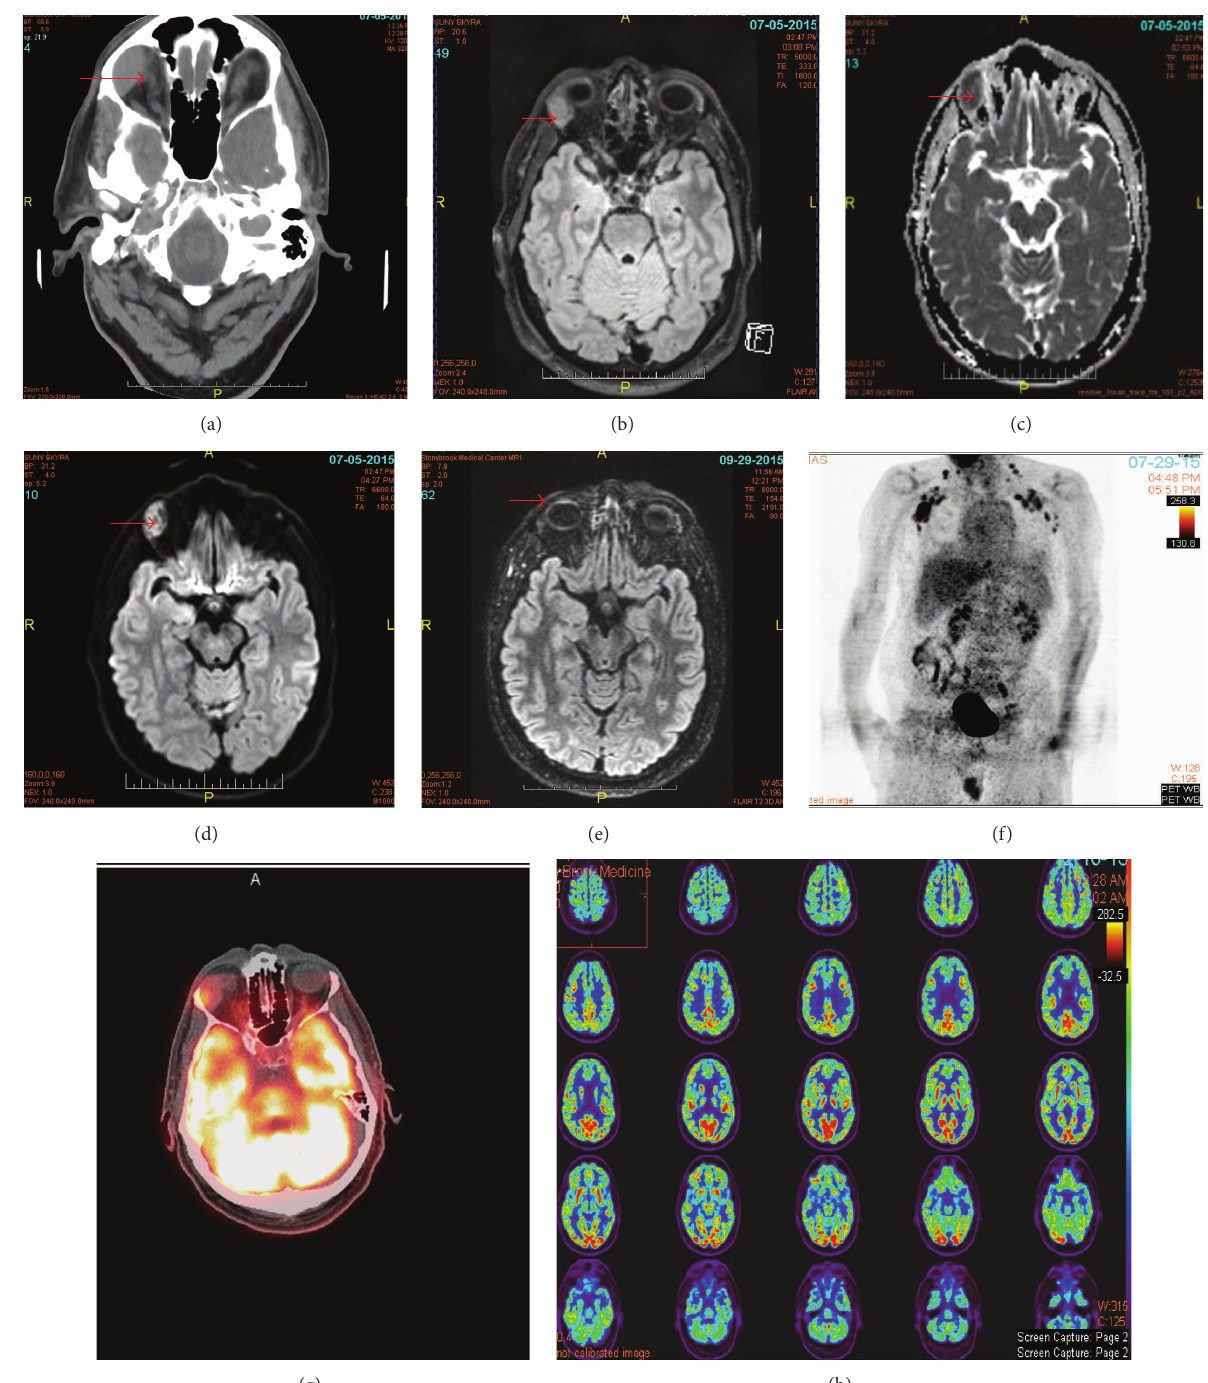
Figure 1: Head CT revealing a lacrimal gland mass (a). Lacrimal gland mass on initial Axial FLAIR (b). Restricted diffusion in the lacrimal glass mass (c and d). Repeat MRI after initiation of prednisone revealing decreased size of lacrimal lesion (e). Hypermetabolic foci corresponding to lymph nodes in bilateral neck, axillary regions, chest, pelvis, and inguinal regions on whole-body PET/CT (f). Prominent hypermetabolic lesion in the right lateral orbit before prednisone (g). No evidence of hypermetabolic lesions or regional hypometabolism within the brain on PET/MRI 5 months after prednisone and infliximab